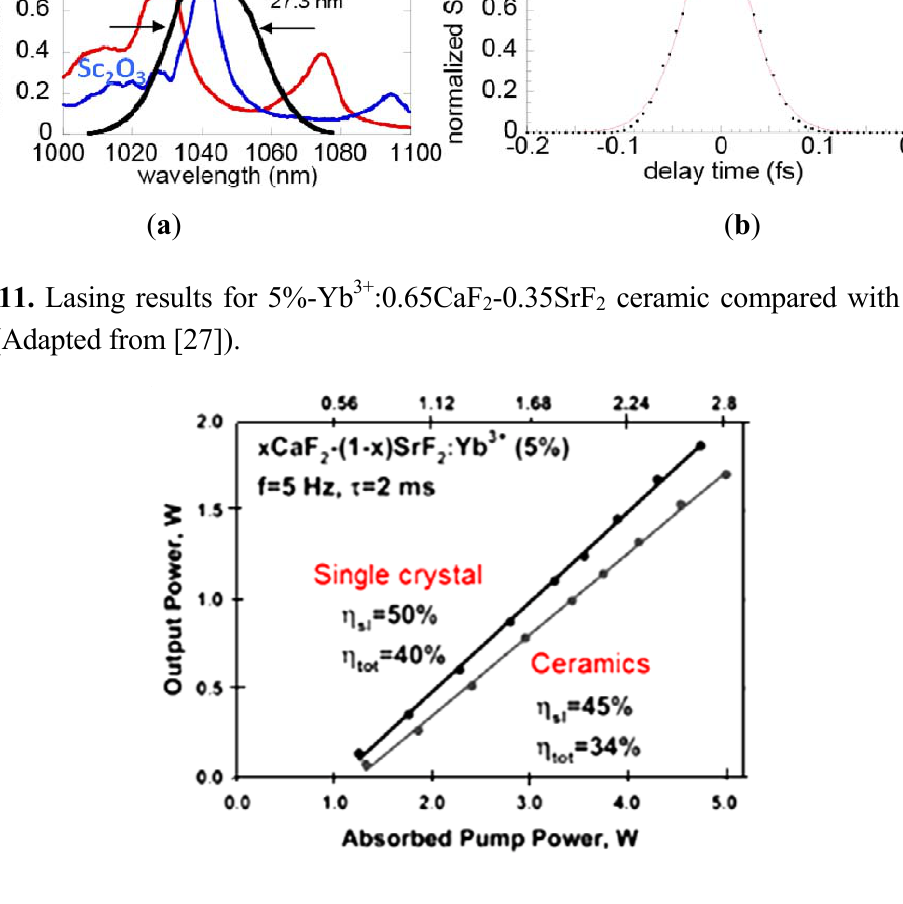
O ceramic behind a 1.8% Yb:Sc 2 3